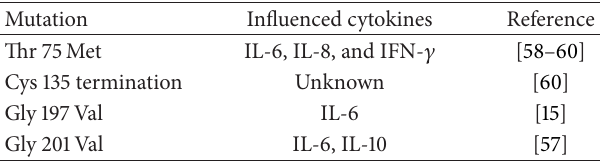
Table 2: Human PSMB8 (LMP7 gene)